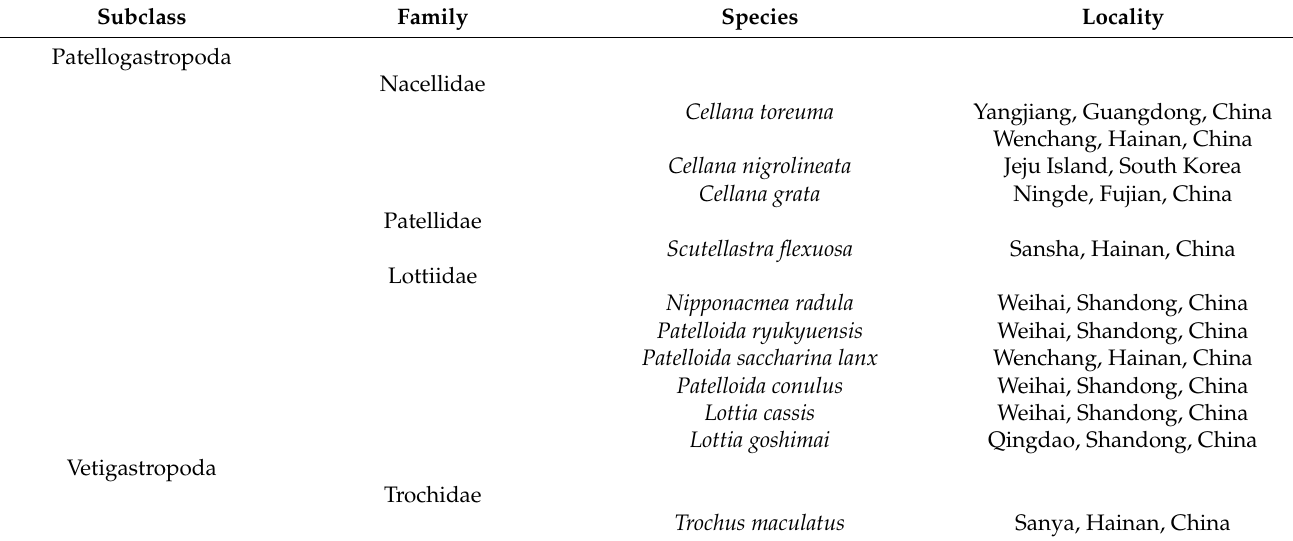
Table 1. List of species used in this study. Subclass Family